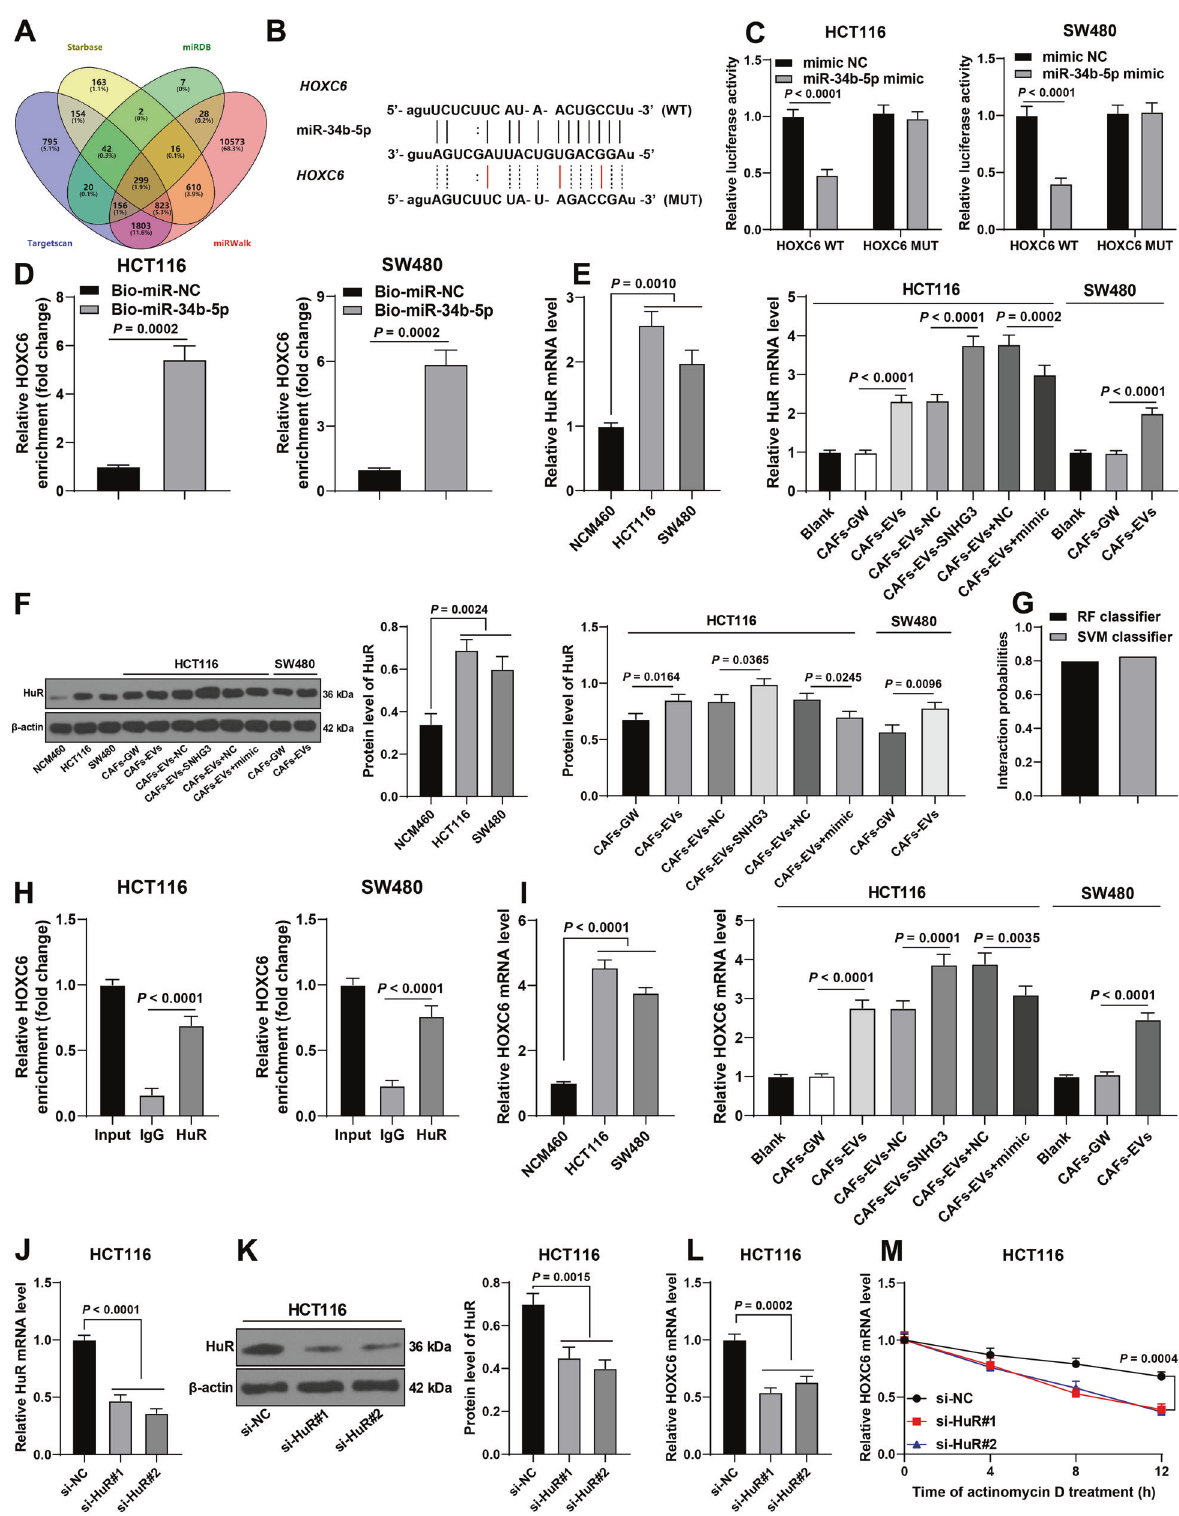
con fi rmed the binding relationship between HuR and HOXC6. After HuR siRNA was transfected into HCT116 cells, there was a reduction in HOXC6 mRNA expression levels. Meanwhile, existing evidence suggests that HOXC6 expressions are elevated in CRC in comparison to normal mucosa, such that higher